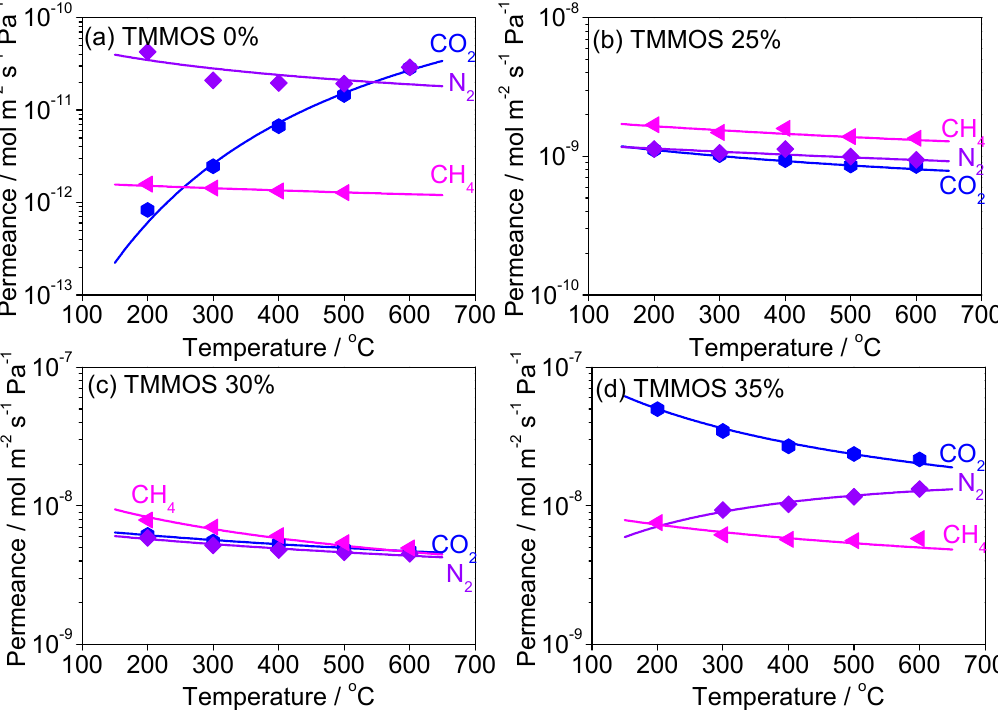
Figure 11. Fitting results by the gas translational diffusion model points are the experimental data and curves (open points were not used for fitting), blue: CO 2 , violet: N 2 , pink: CH 4 , ( a ) TMMOS 0%,